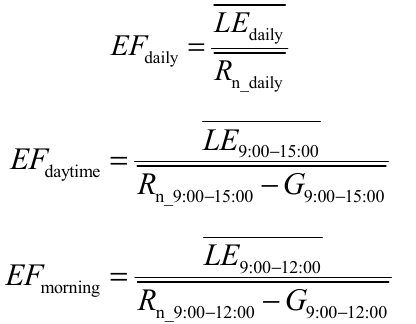
Figure 3. Relationship between P station on 24 April (DOY 114), 29 May (DOY 149) and 21 July (DOY 202) 2010 s calculated by simulated H and T ( P rad